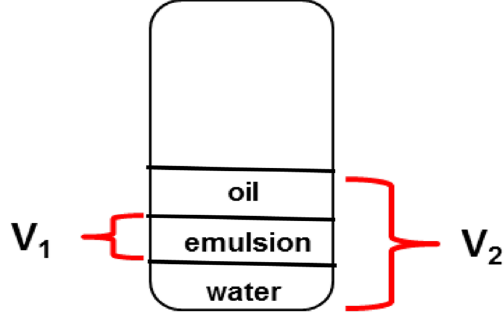
Fig. 2 Schematic diagram for measurement of percentage of emul- sion after